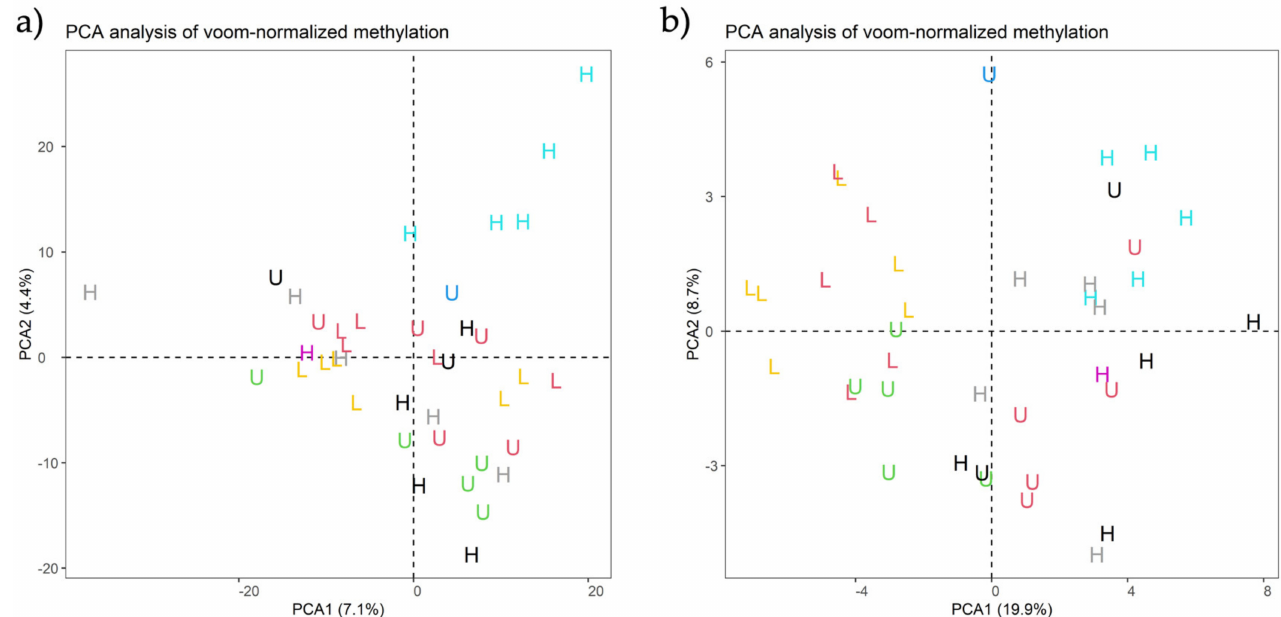
Figure 2. ( a , b ). Principal component analysis (PCA) of ( a ) all 1209 regions of interest (ROIs) and ( b ) the 46 significant Differentially Methylated Regions (DMRs) across 39 samples from HF ( n = 15), LF ( n = 11), and UF ( n = 13) experimental groups represented by the letters H, L, and U,